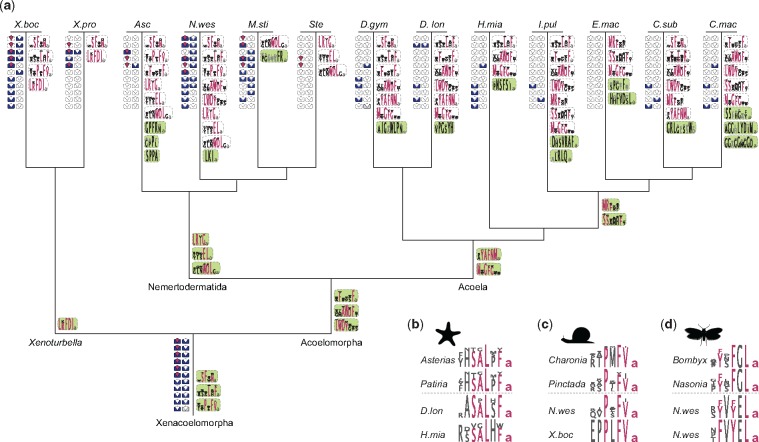
Distribution of peptidergic systems in Xenacoelomorpha and comparision of xenacoelomorph MCPs. (a) Distribution of detected ancestral bilaterian systems (left side of a branch) and novel MCPs (right side of a branch) in the 13 xenacoelomorph species. Symbols and order of bilaterian systems are similar to figure 1. Newly evolved MCPs are shown with a green background, next to the branch where they evolved. (b) Comparison of two xenacoelomorph LxFamides with echinoderm L-type SALMFamides of Asterias rubens and Patiria miniata. (c) Comparison of two xenacoelomorph PxFVamides with molluskan PxFVamides of Charonia tritonis and Pinctada fucata. (d) Comparison of two xenacoelomorph ELamides with insect allatostatin A of Bombyx mori and Nasonia vitripennis. Residues of peptide sequence logos that are conserved across species are highlighted in magenta.